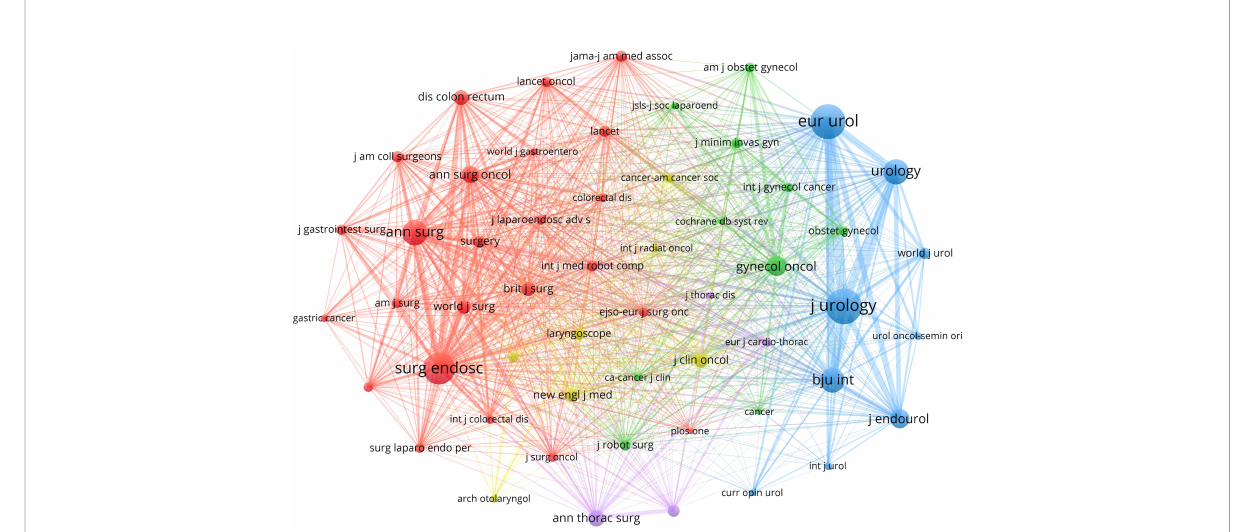
FIGURE 5 Knowledge map of co-cited journals network related to robotic surgery in oncology. The size of the nodes is positively related to the citation frequency of the journal. The color of the nodes represents different clusters. The lines between the nodes represent the co-citation relationship between journals. The thickness of the lines is directly proportional to the co-citation strength. From: VOSviewer.